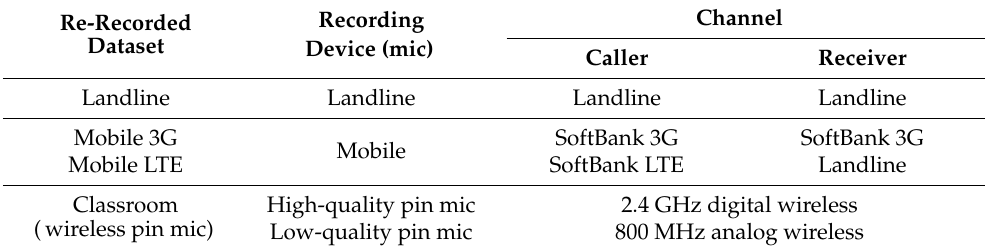
Table 1. Recording devices and transmission channels for re-recorded speech Re-Recorded